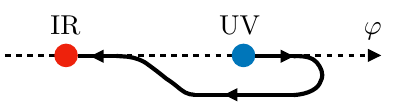
Figure 4. Schematic structure of a (cid:12)eld theory with an RG (cid:13)ow exhibiting a